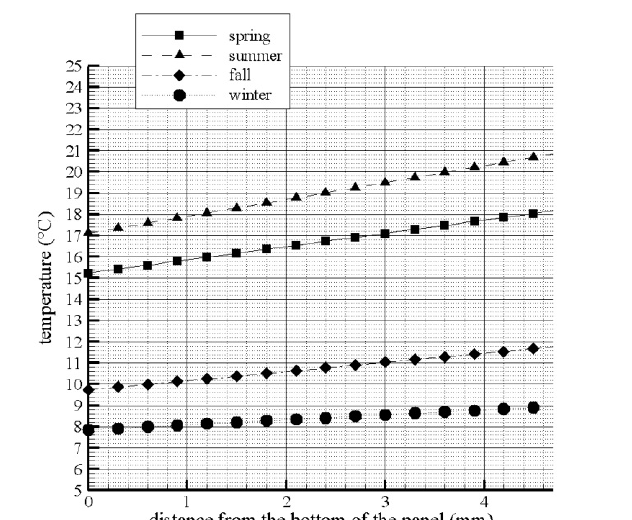
Figure 9. Temperature distribution in panel for different months on average Installation of panels on dam surface causes to reduce panel operation temperature (figure 7); and so increase the panel efficiency and the power generation. The panel annual average efficiency is 19.7% when it installs on water and its annual average efficiency is 19.2% when it installs on the ground. This results show an increase of 2.6% in panel efficiency. This increase in efficiency causes to generate 4 million kWh additional electricity power in the year by these number of panels. Figure 8 compares amount of power generation for two situations: when panels are install on water and when panels are install on ground.